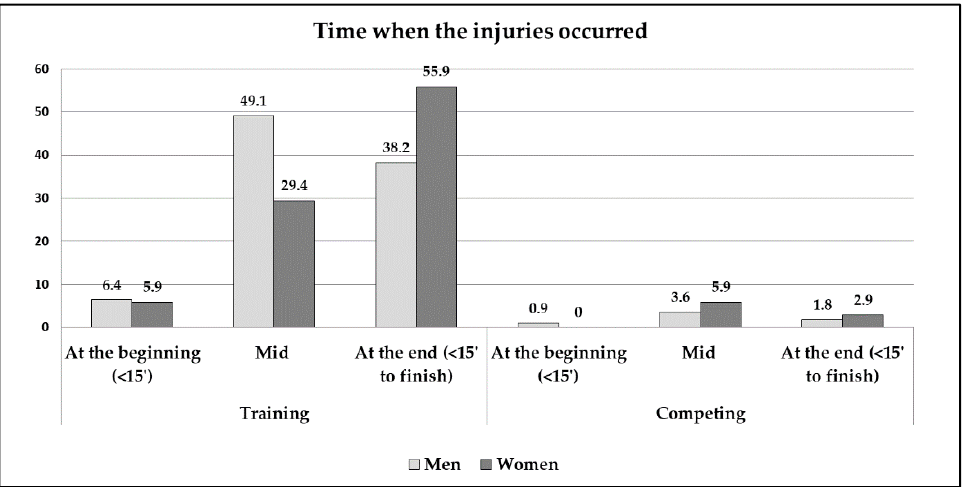
Figure 2. The time when the injuries occurred.